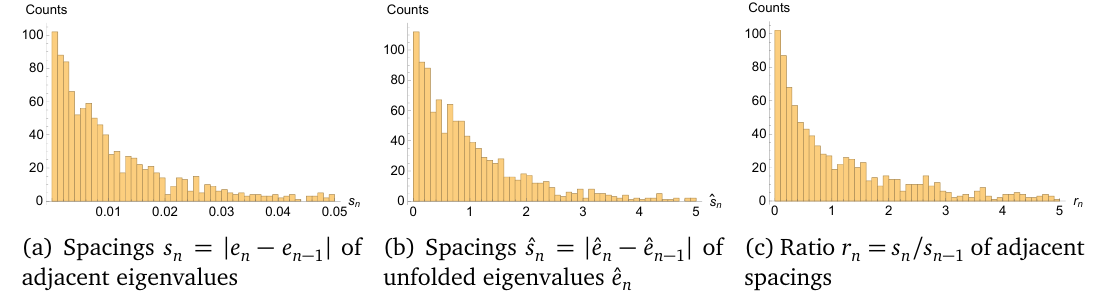
Figure 1: Histograms for the spacings and ratios of the N = 1077 eigenvalues of the c Lindbladian on L = 11 sites after the degeneracies have been removed. 1 The chosen symmetry sector is defined by k = 2 π/ 11 ( e ik is the eigenvalue un- ) = ( 1,2,3,5 ) where n der translation by one site) and ( n , n , n , n 1 2 3 4 ber of times the local state i = 1,2,3,4 appears in the tensor-product-state (the c sector has local dimension 4 on each site). This corresponds to the Cartan 1 − C 2 charges ( J z , J z , C 1 1 2